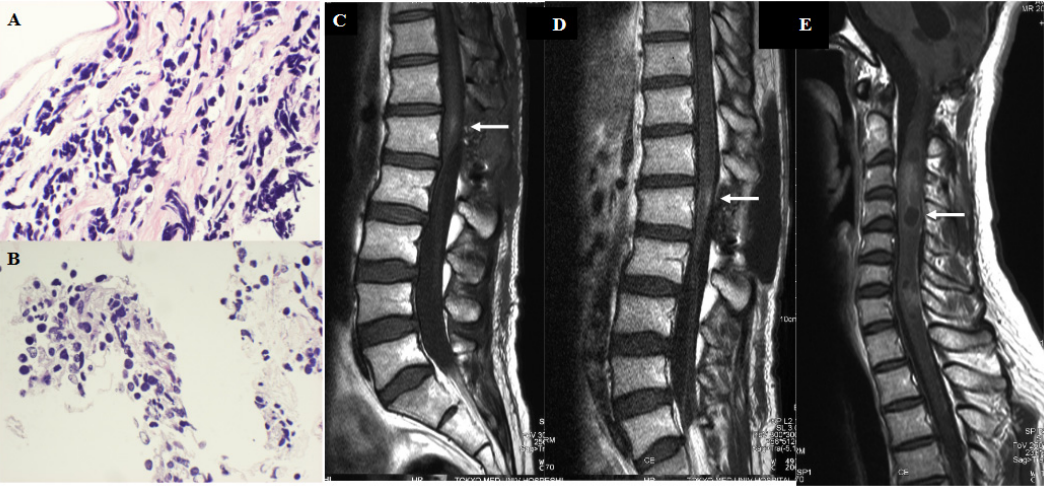
Figure 3. Radio-pathological course of the patient after the lumbar surgery. ( A , B ) Histopathological findings of the resected tumor in the conus medullaris demonstrated a cluster of small round cell tumor cells with a high N/C ratio (×400). ( C ): Postoperative gadolinium-enhanced T1-weighted im- age of the lumbar spine displayed a faint tumor nodule (white arrow) in the conus medullaris with- out enhancement of the meninges of the cauda equina. ( D , E ) Gadolinium-enhanced T1-weighted MRI of the lumbar spine ( D ) and cervical spine ( E ) taken 2 months after the lumbar surgery. The lumbar lesion displayed faint tumor enhancement (( D ): white arrow), and the heterogeneous en- hanced intramedullary mass was located between the C3 and C7 levels (( E ): white arrow). 5. Discussion In 1980, the first case of PDT performed on a human patient for a malignant brain tumor was reported from Italy [10,11], and thereafter PDT for malignant brain tumors has been performed frequently in many countries for the past 40 years. However, to the best of our knowledge, there has been no case reports to date of PDT performed for a malig- nant spinal cord tumor. Malignant spinal cord tumors show histological similarities to malignant intracranial tumors [6], and therefore, we expected PDT to show clinically effi- cacy. However, spinal cord tumors comprise only 2% to 4% of central nervous system tumors, and, in particular, the malignant histology is an extremely rare occurrence. 6) Fur- thermore, neuro-oncology specialists are not necessarily in charge of the treatment of spi- nal cord tumors. Owing to these reasons, it is possible that PDT has not been recognized as a treatment option by physicians who usually treat malignant the spinal cord tumors. In fact, according to a recent report from Japan of 1033 cases of intramedullary spinal cord tumors in the previous 12 years [12], there were only 29 cases (2.8%) of tumors demon- strating a malignant histology including WHO grades 3 or 4. Furthermore, in a study of 48 cases during 7 years from France [13], there were only 3 cases (6.3%) of tumors demon- strating malignant histology. Among Japanese cases, after surgery, the adjuvant radio- therapy was performed on 130 patients (12.6%) including those with grade 2